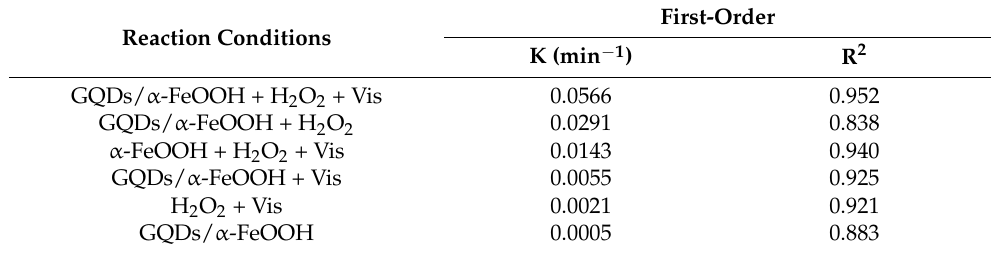
Table 1. CIP degradation kinetic constants under different experimental conditions.